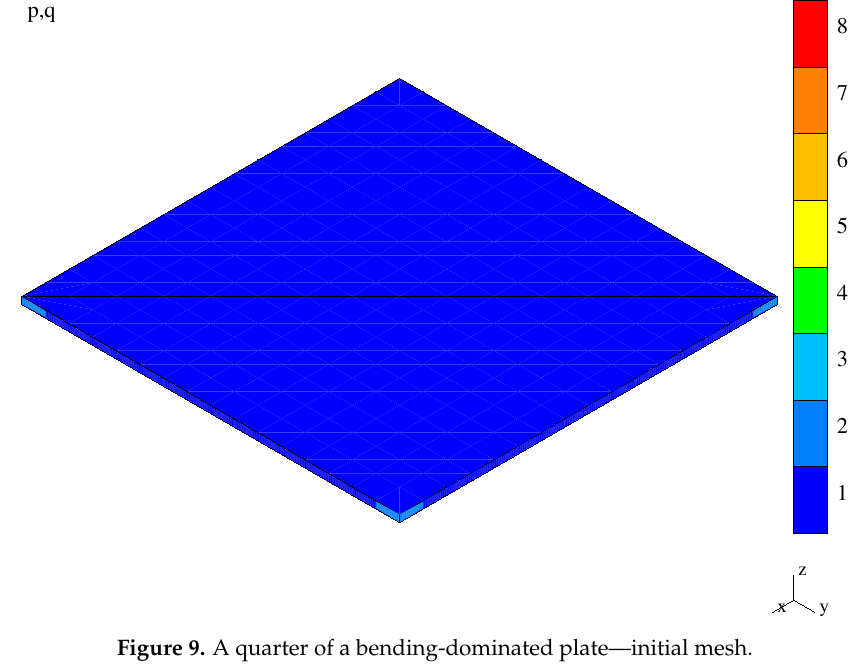
Figure 9. A quarter of a bending-dominated plate—initial mesh.